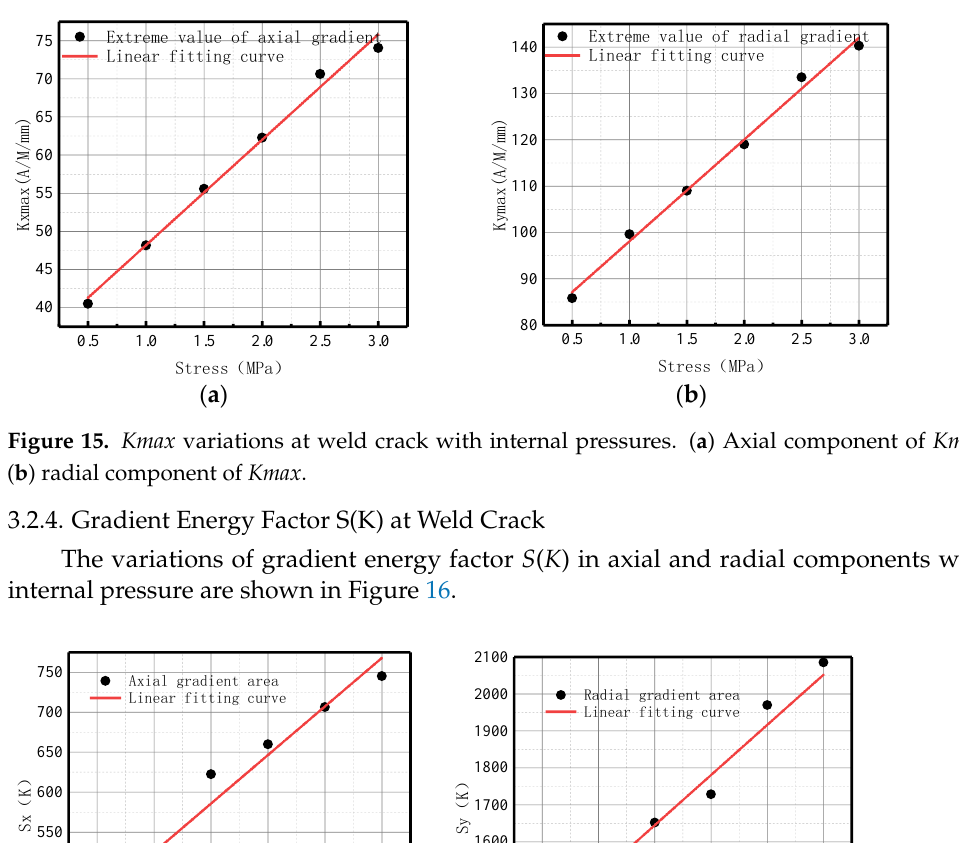
( b ) Figure 14. Magnetic signal gradient K at weld crack changes with internal pressures. ( a ) The axial gradient component Kx; ( b ) the radial gradient component Ky. It was found that the magnetic field strength gradient K for the axial and radial com-